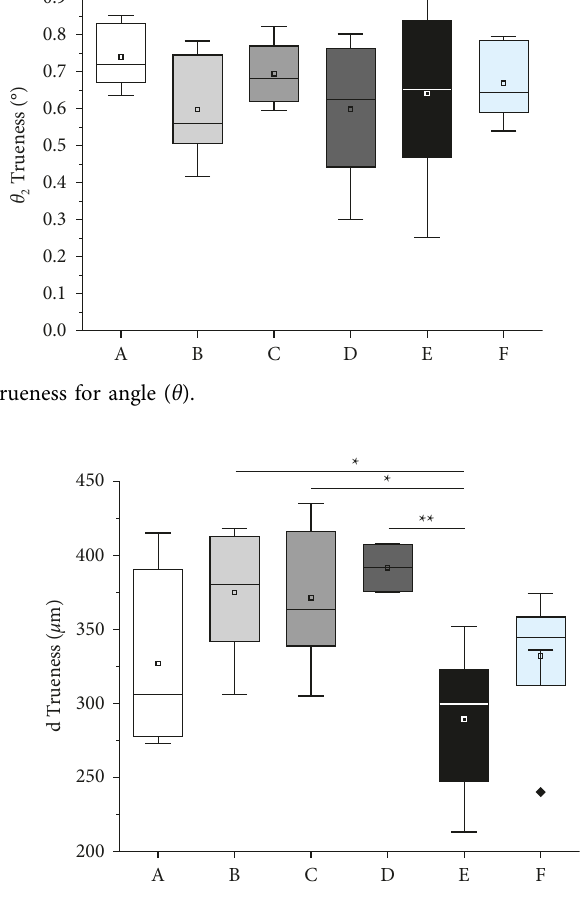
Figure 7: Boxplots of trueness for distance ( d